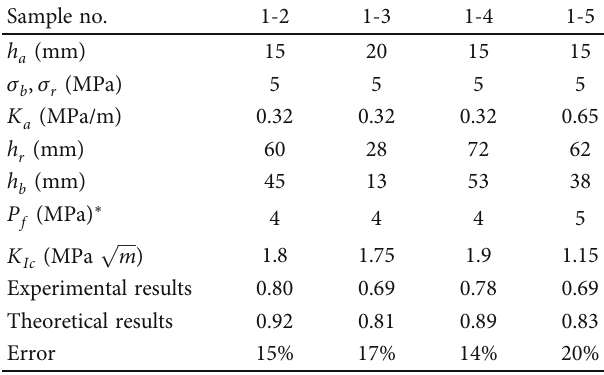
Figure 6: The ratio of the fracture height in the reservoir and the interlayer ( h Table 5: Experimental results of physical model and solution results of theoretical model.